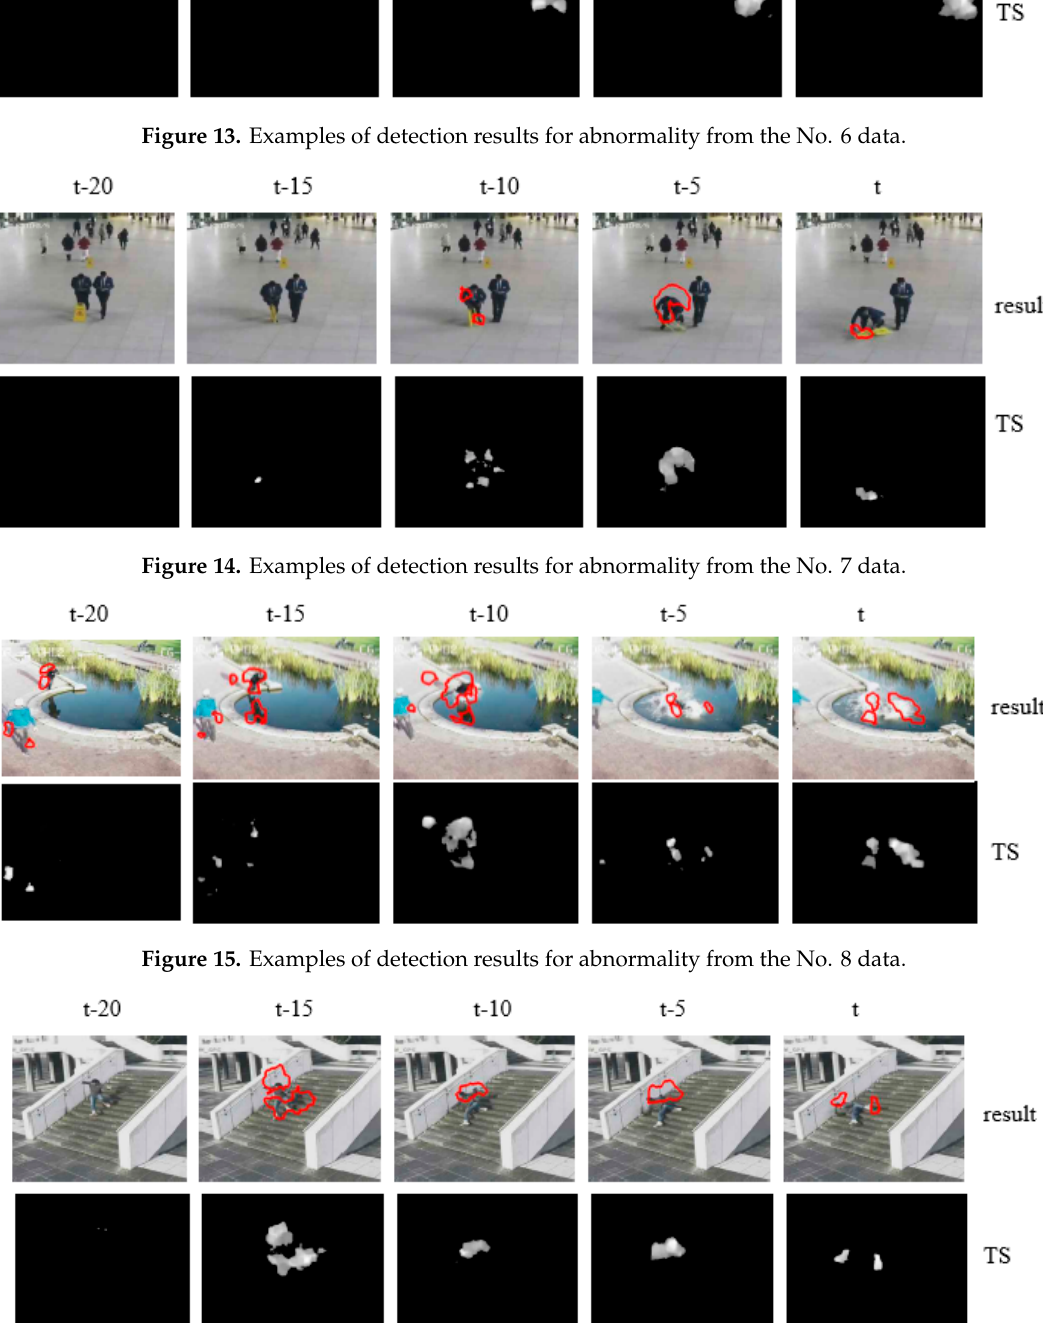
Figure 16. Examples of detection results for abnormality from the No. 9 data.